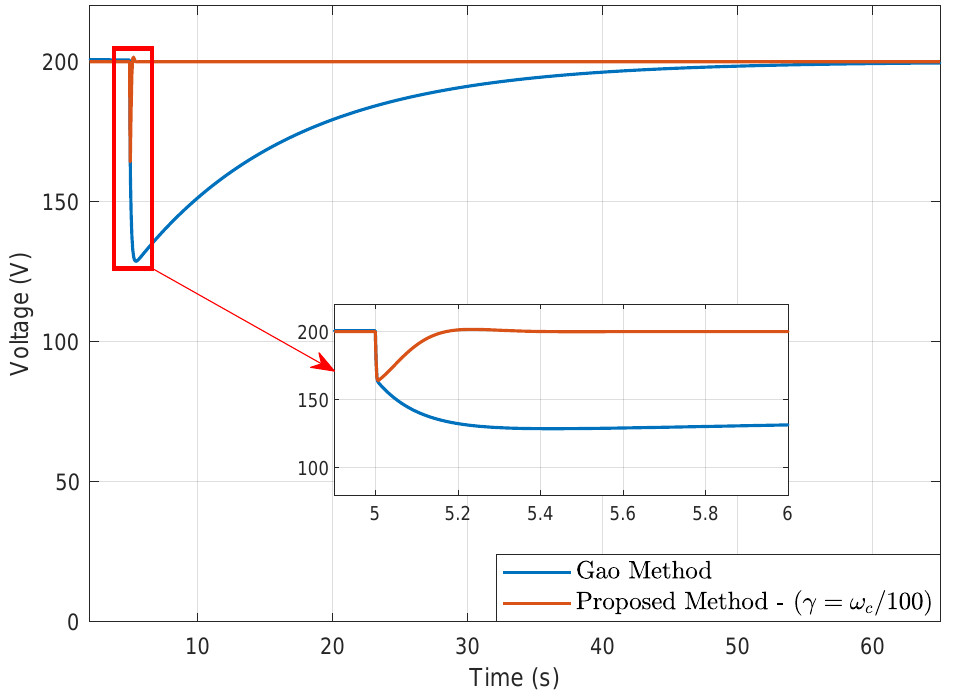
Figure 18. Simulation results showing the output voltage behavior when the voltage controller is tuned using Gao’s method and when the proposed tuning method with γ = ω c